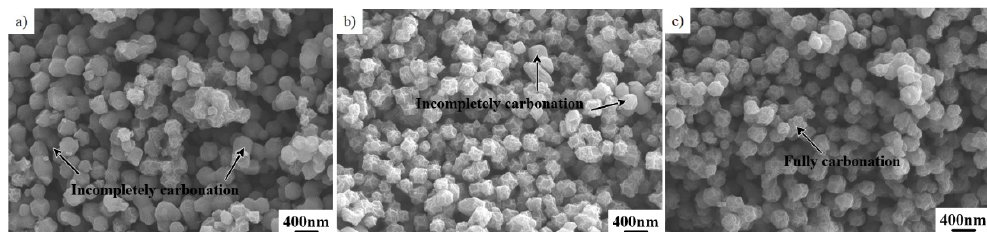
Figure 4. ( a ) The microstructure of Co-ZIF–8 pyrolyzed with a heating rate of 10 °C/min; ( b ) The microstructure of Co-ZIF–8 pyrolyzed with a heating rate of 5 °C/min; ( c ) The microstructure of Co-ZIF–8 pyrolyzed with a heating rate of 2 °C/min.